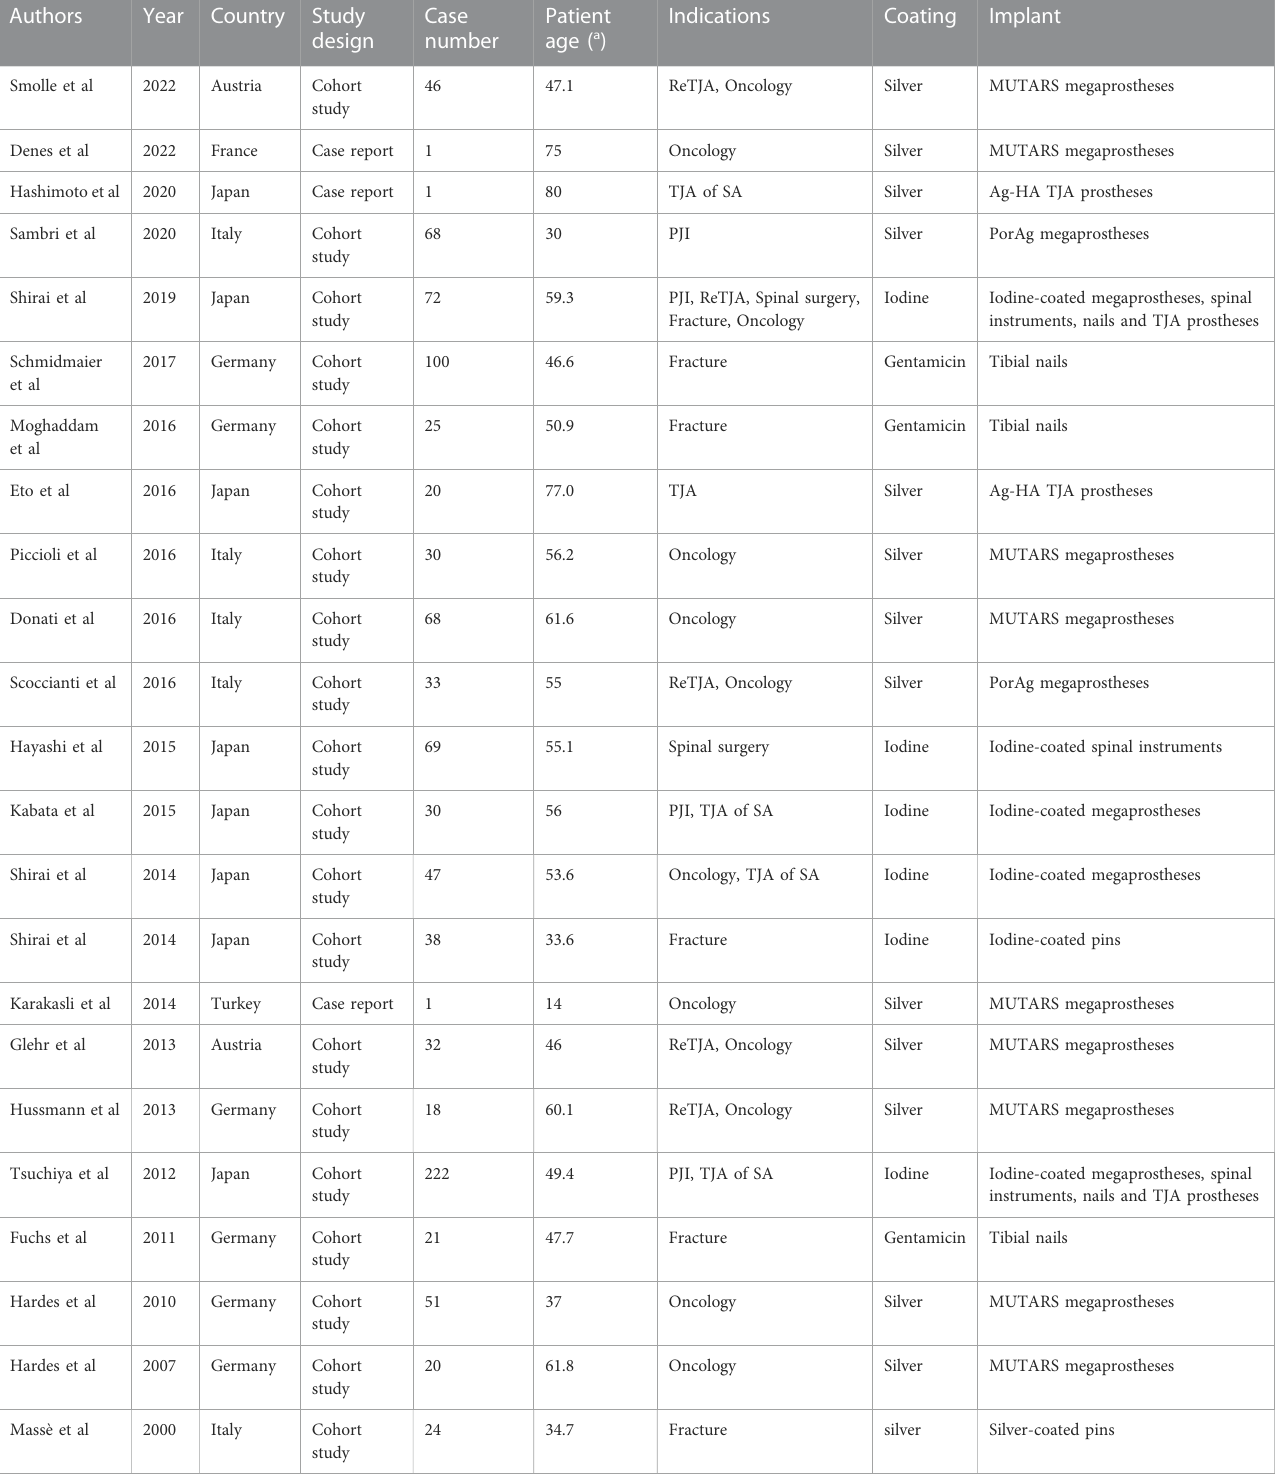
TABLE 1 Characteristics of the included